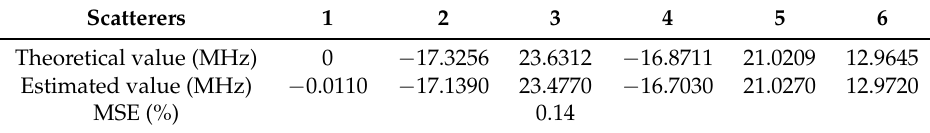
Table 2. Estimated spatial frequency and its MSE from IO(B) using the proposed CS method.